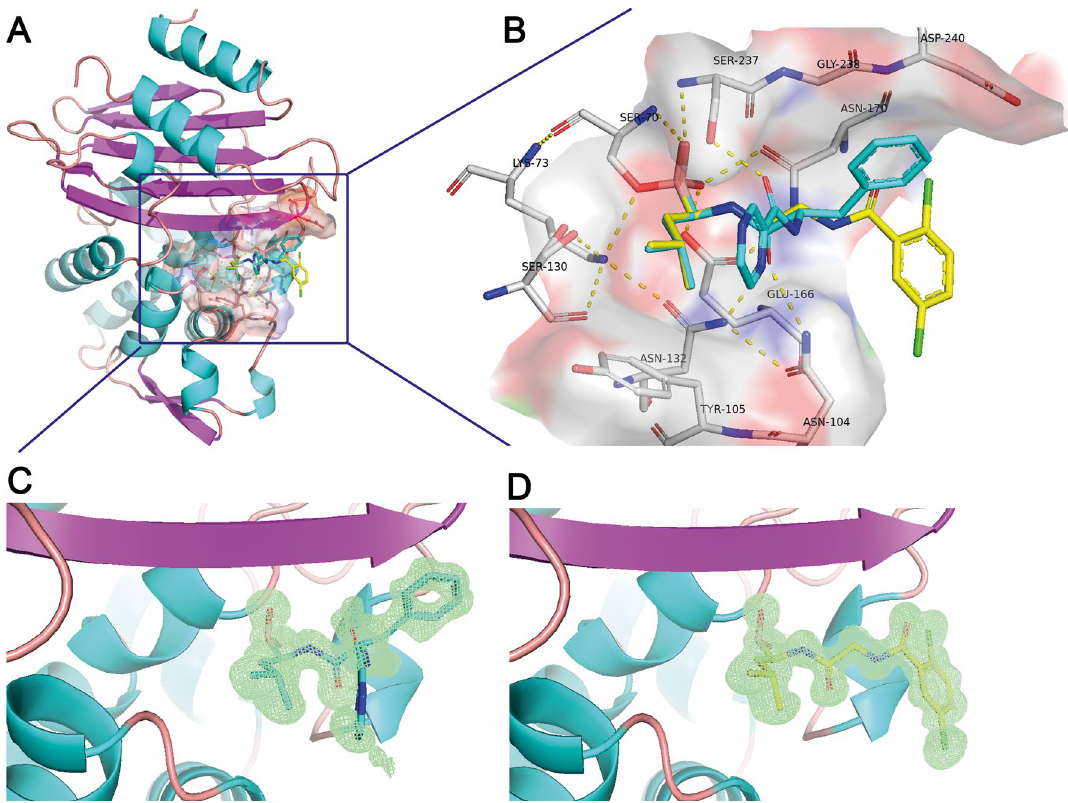
Figure 2. Ribbon plot of the overall structure of CTX-M-14. The active site region is highlighted by a surface representation and the active site residues and covalently bound Bortezomib/Ixazomib is shown as sticks ( A ). The close-up of the active site region ( B ) reveals the hydrogen bonding network among the active site residues. The covalently bound inhibitors are super positioned and shown in sticks with C-atoms colored in cyan and yellow for Bortezomib and Ixazomib, respectively. The corresponding F o — F c polder omit maps of the inhibitors in complex with the refined models of CTX-M-14 are shown in light green and contoured at 3σ ( C and D